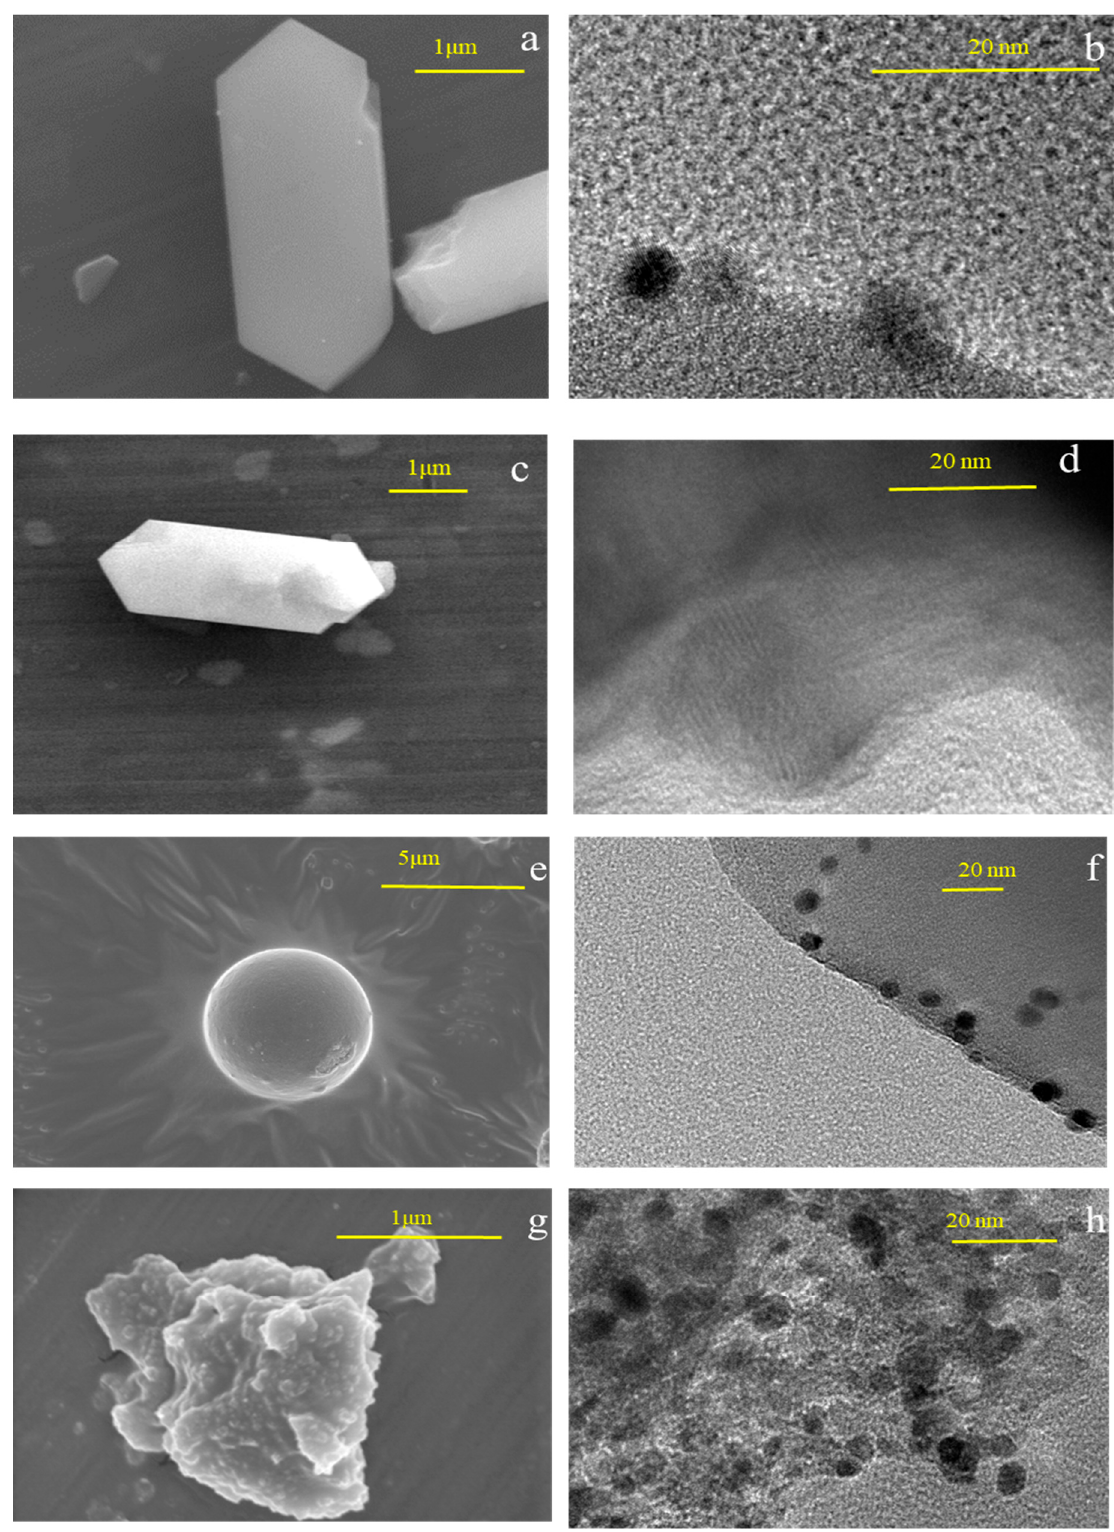
Figure 10. SEM/TEM analysis of the catalyst: ( a ) SEM analysis of Pt@Zsm-5; ( b ) TEM analysis of Pt@Zsm-5; ( c ) SEM analysis of Pt@Hzsm-5; ( d ) TEM analysis of Pt@Hzsm-5; ( e ) SEM analysis of Pt@SBA-15; ( f ) TEM analysis of Pt@SBA-15; ( g ) SEM analysis of Pt@Al 2 O 3 ; ( h ) TEM analysis of Pt@Al 2 O 3 .